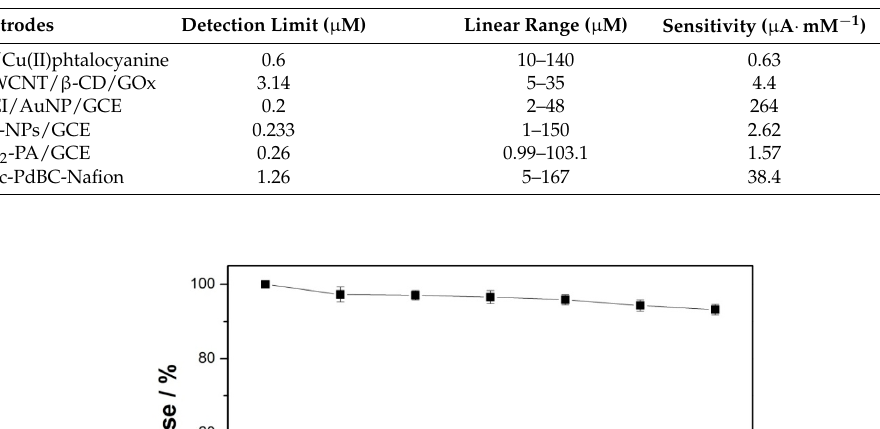
Table 1. Sensing performance comparison of different sensors toward dopamine.